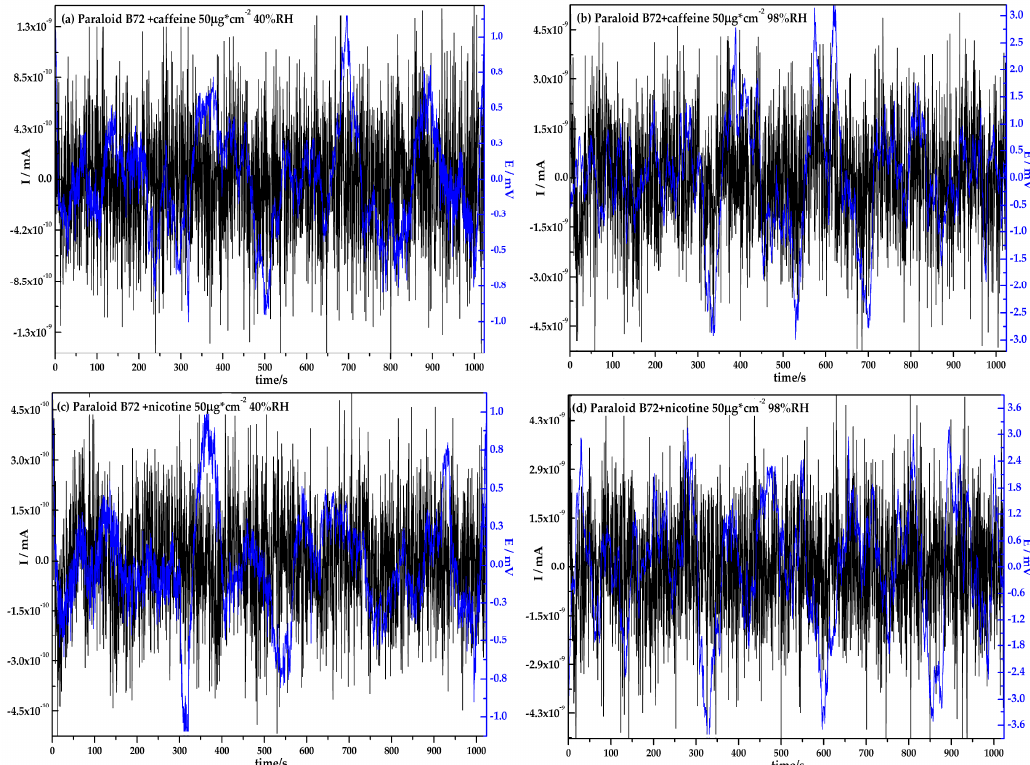
Figure 5. Cast iron’s time series in current and potential for ( a ) Paraloid B72 + 50 µ g · cm − 2 with caffeine at 40% RH, ( b ) Paraloid B72 + 50 µ g · cm − 2 with caffeine at 98% RH, ( c ) Paraloid B72 + 50 µ g · cm − 2 with nicotine at 40% of RH, and ( d ) Paraloid B72 + 50 µ g · cm − 2 with nicotine at 98% RH.